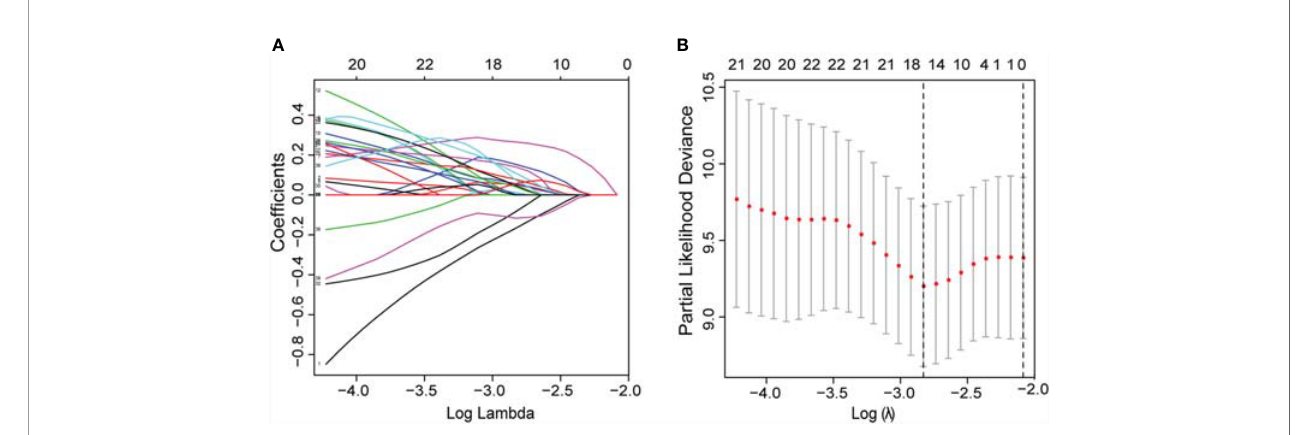
FIGURE 3 | LASSO was utilized to identify the radiomic features that highly correlated with the PFI of KIRC patients. (A) LASSO path map, radiomic features corresponding to different alpha features. (B) Optimal lambda resulted in 16 non-zero coef fi cients for the radiomic signature. PFI, progression-free interval; LASSO, least absolute shrinkage and selection operator; KIRC, Kidney Renal Clear Cell Carcinoma .